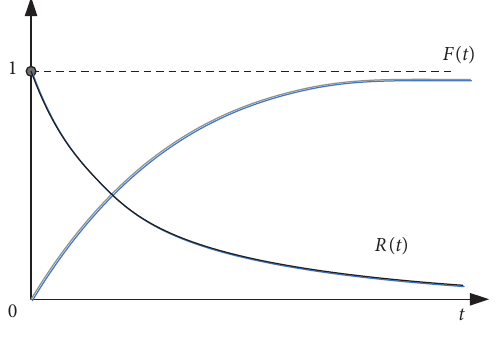
Figure 3: Reliability function and failure distribution function